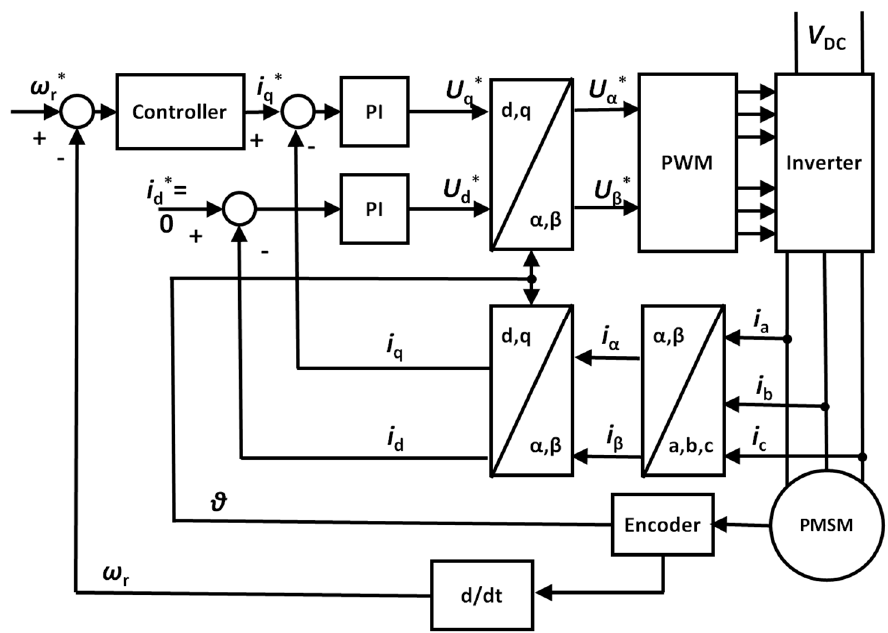
Figure 3. Typical block diagram of field oriented control of PMSM.